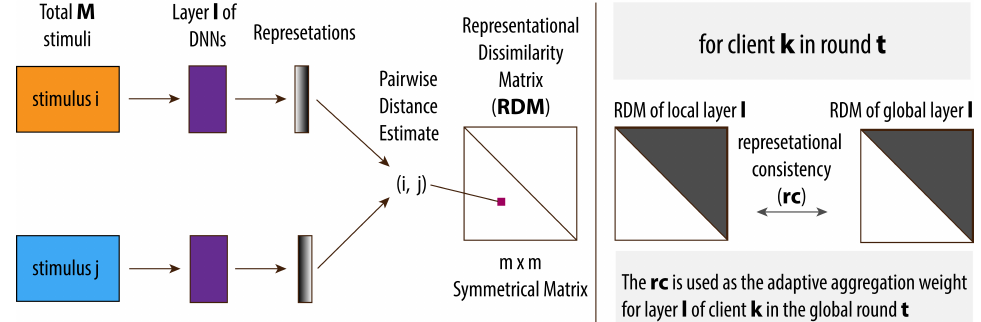
Figure 3. The schematic diagram of